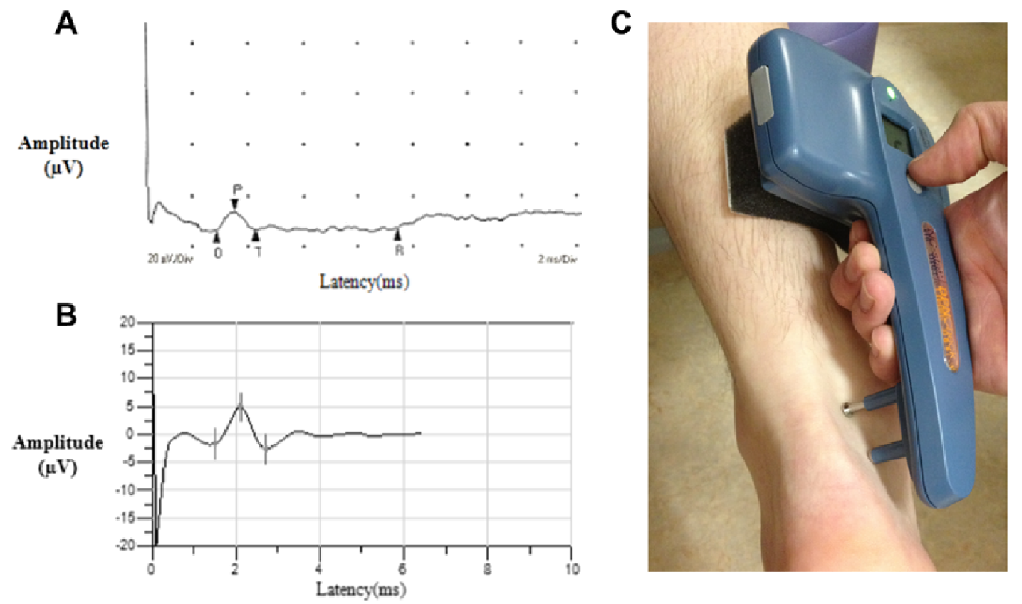
Figure 1. Sample nerve conduction recordings from standard NCS (A) and the point-of-care device (B) from a 60-year-old female with type 2 diabetes and an image of the point-of-care procedure (C). Panel A: Sample standard NCS recording. Sural nerve amplitude potential was 6.8 m V and conduction velocity was 48.3 m/s. Panel B: Sample recording from the point-of-care device. Sural nerve amplitude potential was 8 m V and conduction velocity was 56 m/s. Panel C: The device was placed on the lateral aspect of the leg and the sural nerve was stimulated and recorded by the electrical probes and biosensor, respectively.